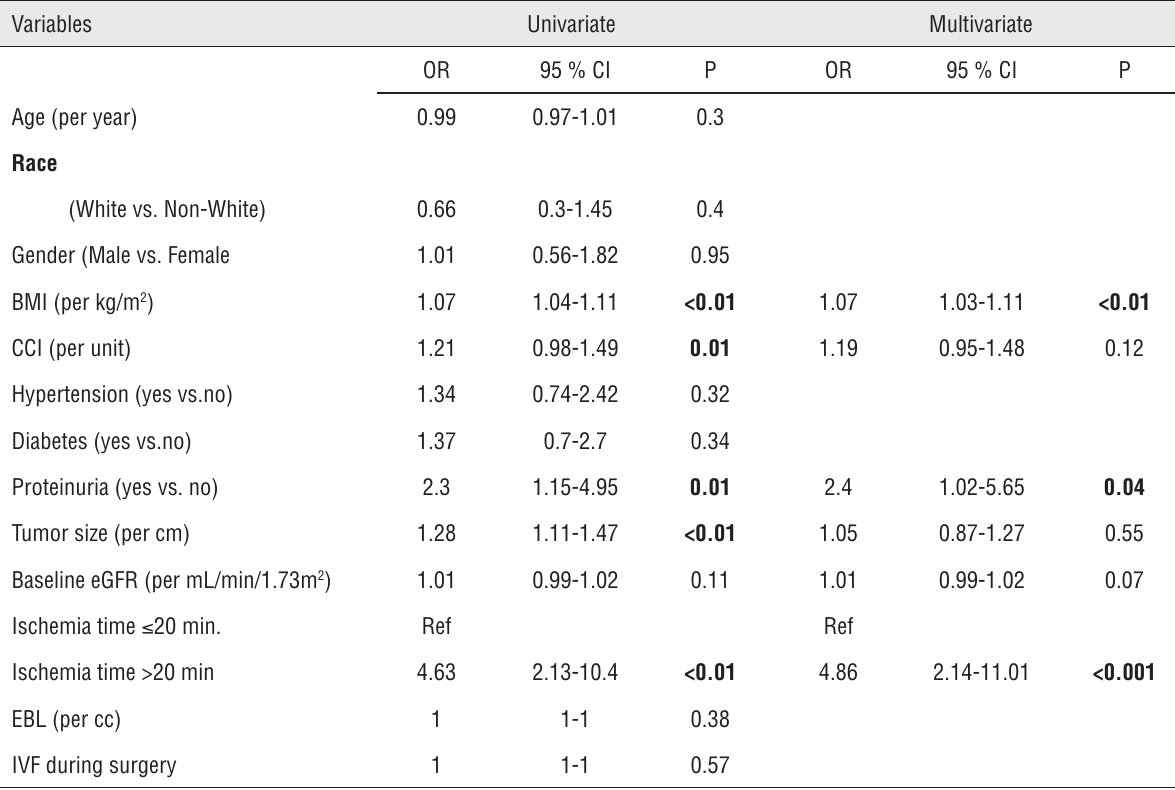
Table 5 - Logistic regression analysis predicting AKI after